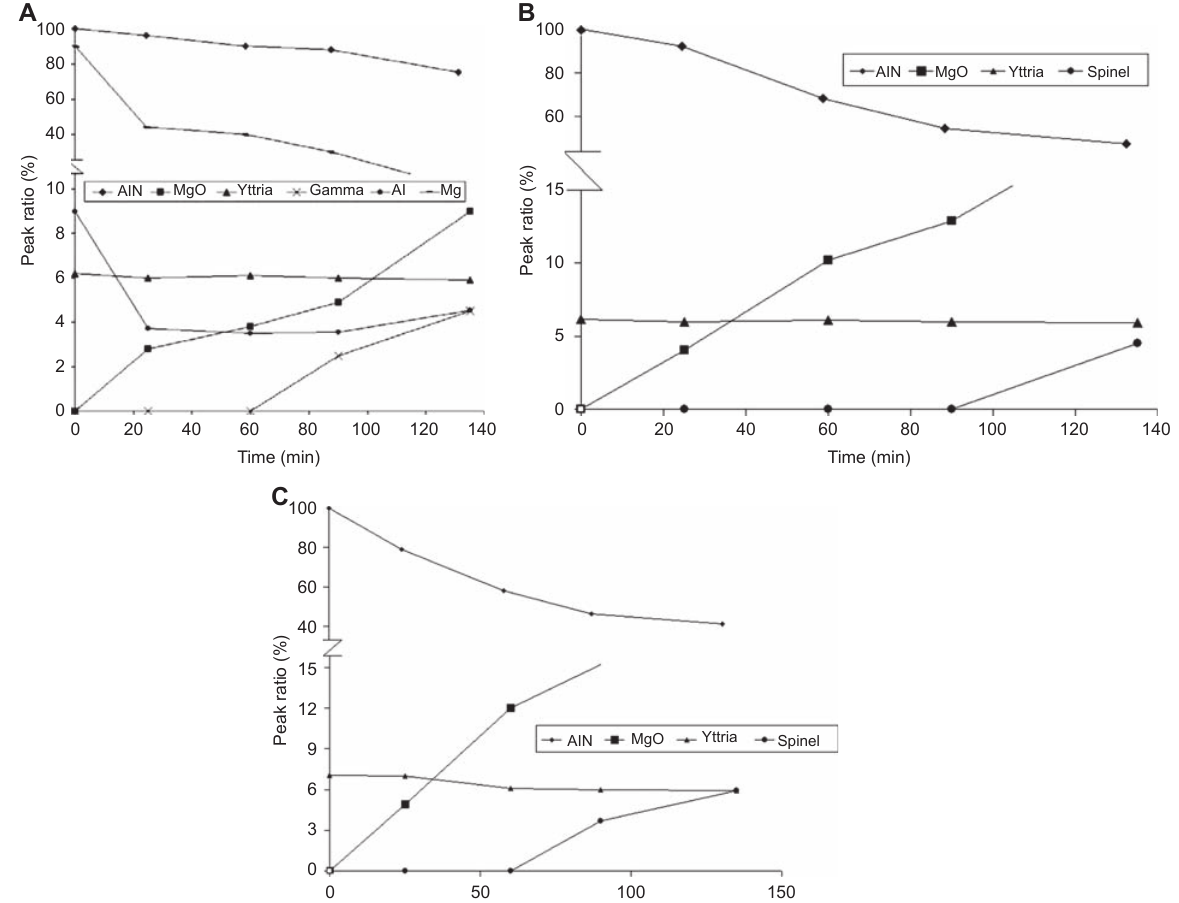
The magnesium content decreases due to evaporation and oxidation. Figure 6 B and C depict the effects of process time on the phase contents at 800 ° C and 950 ° C, respectively. They indicate that as holding time increases, the amount of AlN is reduced and the magnesium oxide content increases. In the samples processed at 950 ° C, formation of spinel occurs at shorter holding times (90 min) compared to 135 min for the case of 800 ° C. Also, the rates of magnesia formation